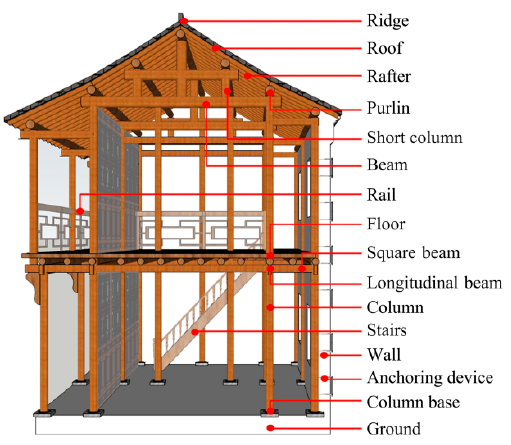
Figure 1. Traditional Chinese timber structural building.